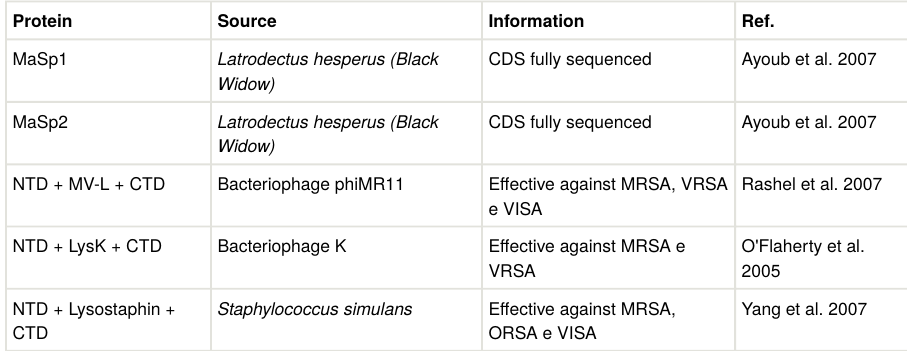
Protein Source Information